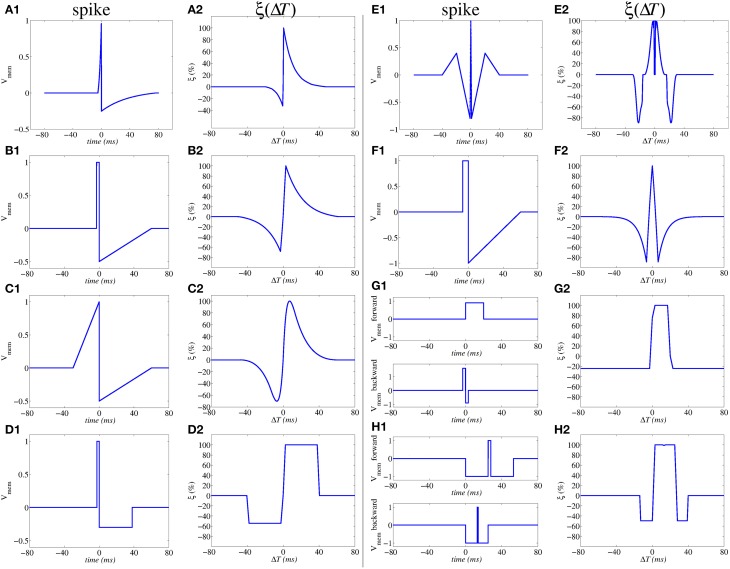
Illustration of influence of action potential shapes on the resulting STDP memristor weight update function ξ(ΔT). Memristor upper and lower thresholds are normalized to amplitudes ±1.0. From (A1,A2) to (E1,E2) the same spike waveform travels forward and backward. In (F1,F2) the forward and backward waveforms are the same but have opposite polarity. In (G1,G2) to (H1,H2) the forward and backward waveforms are different. In (G1,G2), the positive pulse of the backward waveform exceeds amplitude +1.0, thus producing negative STDP update whenever there is a post-synaptic spike alone (G2); otherwise if pre- and post-synaptic spikes happen within a given time window, there will be positive STDP update.